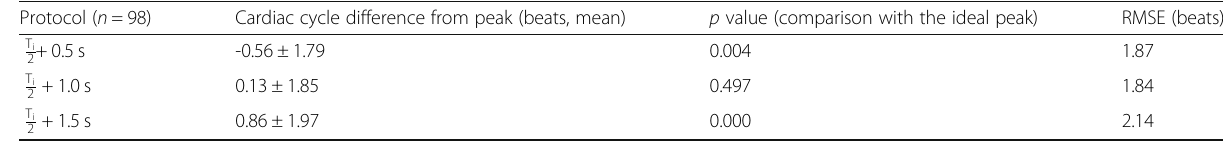
Table 2 Low-dose peak acquisition simulation as compared to ideal peak acquisition Protocol ( n = 98) Cardiac cycle difference from peak (beats,